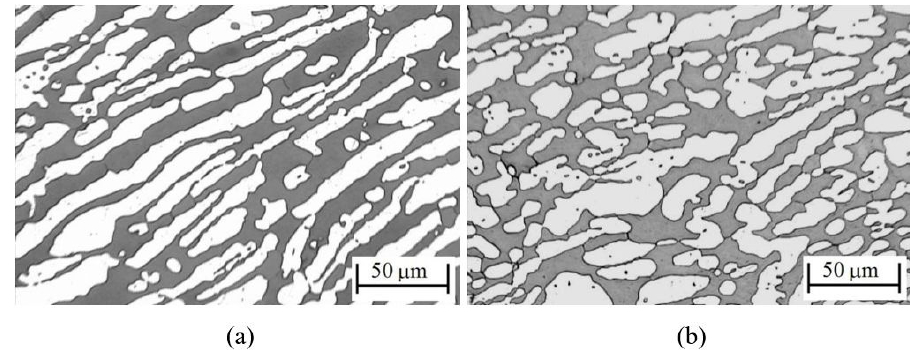
Figure 2. Microstructures of the steels in the cros section: (a) as received (AR-CW); (b) ST-1150.